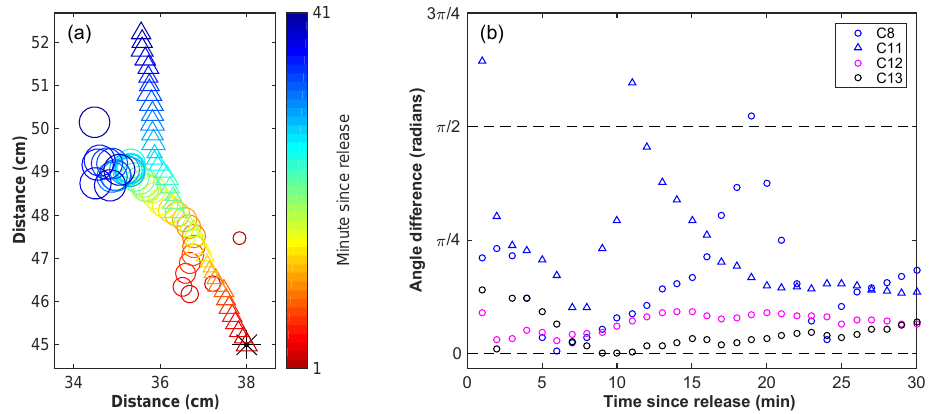
Figure 8. Centroid of mass plotted for case 13 color coded by minute since release (a) . A black asterisk marks release position. In panel (b) the angle between the centroid of mass translation direction and the wind direction has higher correspondence in lower density snow (e.g., case 13).